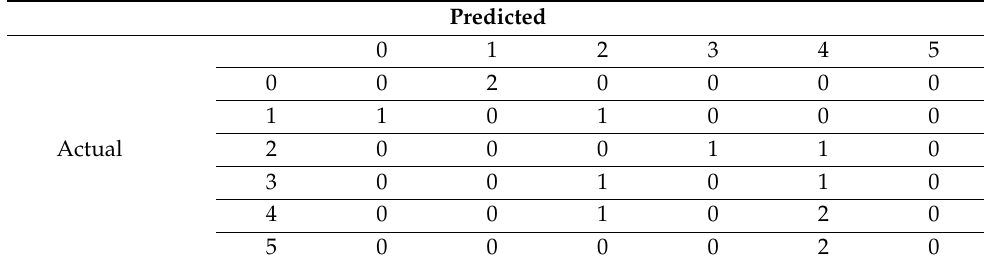
Table 6. Linear SVM; Accuracy 15.4%.